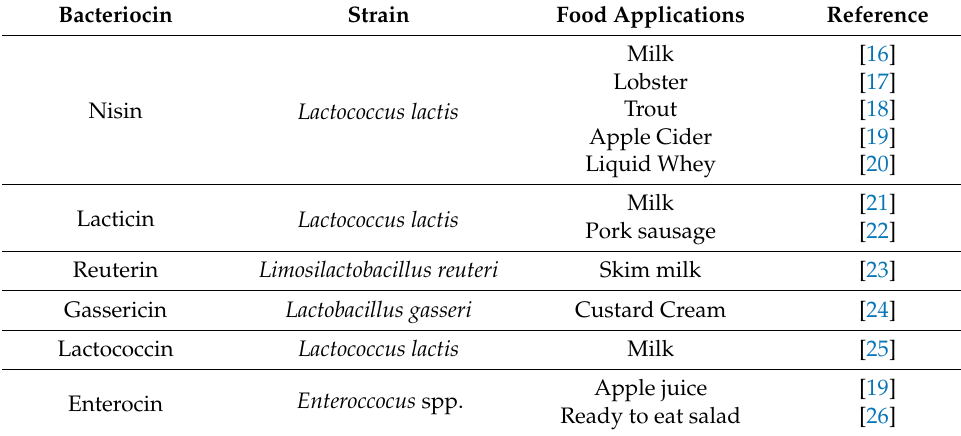
Table 1. LAB bacteriocins and their food applications.